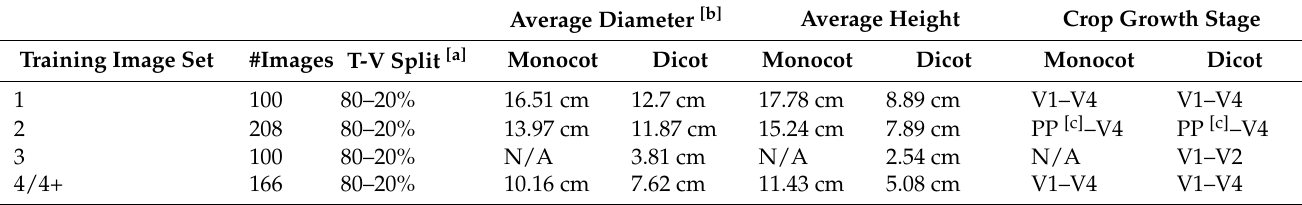
Table 2. Training Image Sets 1–4 creation specifications.